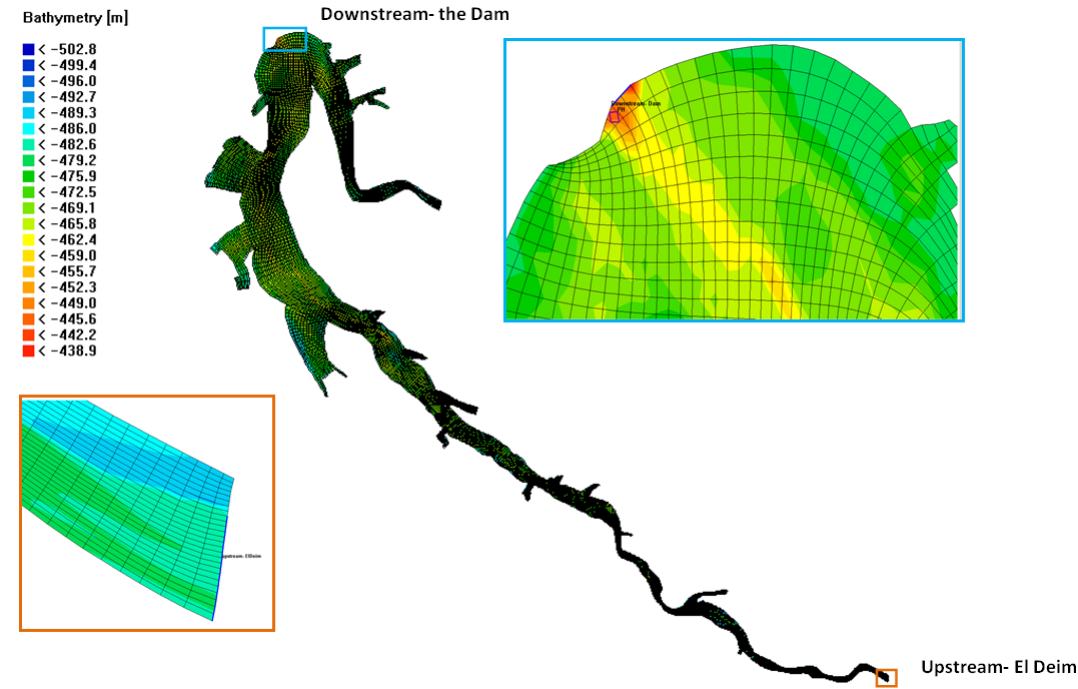
Figure 6. Upstream and downstream boundaries, computational grid and bed elevations in 2009, in ma.s.l. (irrigation